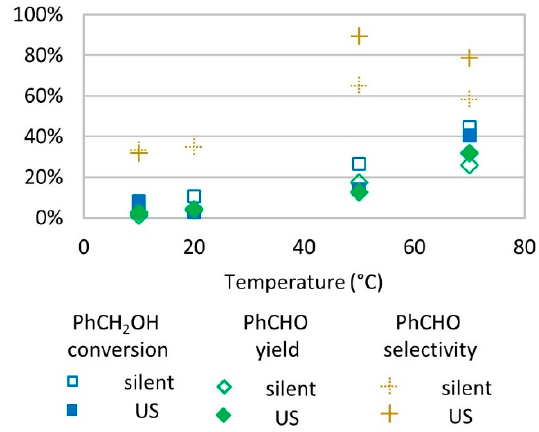
Figure 5. Oxidation of PhCH 2 OH as a function of temperature in silent condition and under US irradiation (20 kHz). Reaction conditions: 571 mM PhCH 2 OH, 1 molar eq. H 2 O 2 ; 1% molar eq. FeSO 4 , 5.61 mL H 2 O, 15 min. Silent conditions: Argon bubbling; US conditions: 20 kHz, P acous = 47.9 W L − 1 h − 1 , 13 mm probe.